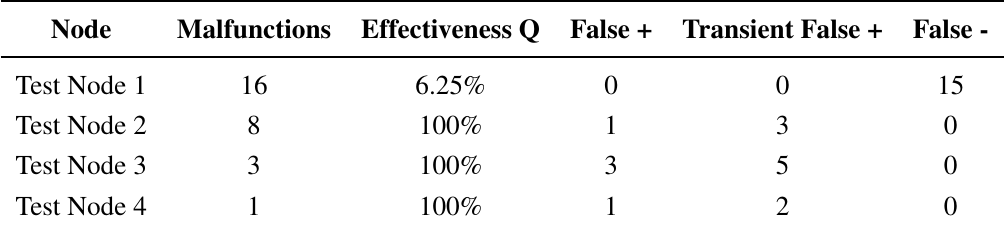
Table 4. The effectiveness of Q is defined as the percentage of actual sensor malfunctions that were correctly classified as fail by Q . A wrong fail classification is defined as a false positive (False +) and a spurious fail classification (only one fail measurement) is defined as a transient false positive. Except for test Node 1, all sensor malfunctions were correctly classified by our detection